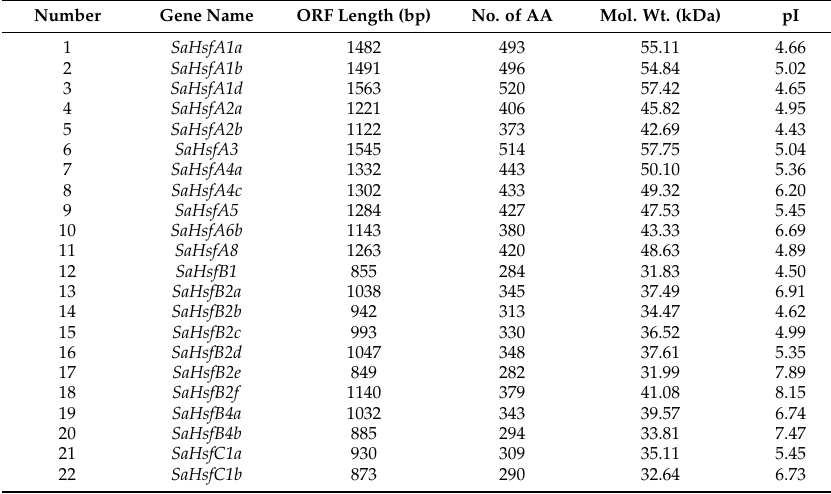
Table 1. The basic information list of the identified heat shock transcription factors (Hsfs) in S. alfredii . Number Gene Name ORF Length (bp) No. of